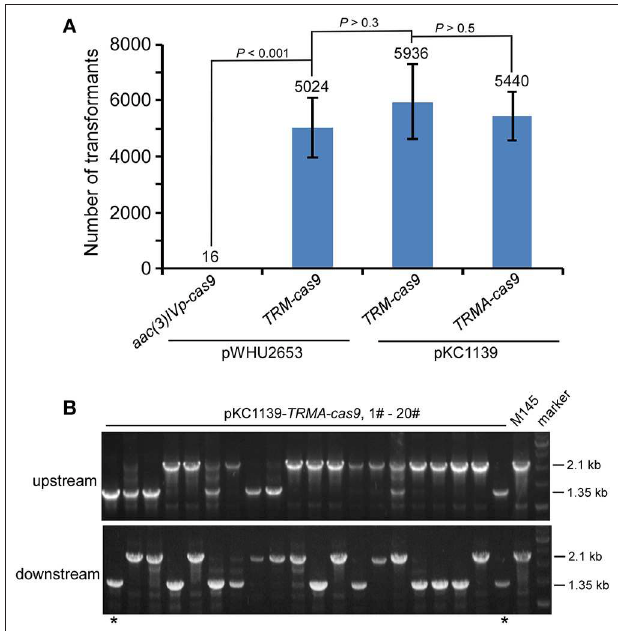
FIGURE 3 | actII-ORF4 deletion in S. coelicolor with engineered Cas9 and atpD overexpression from the pSG5 ori plasmid under non-induction conditions. (A) Transformation efficiency for actII-ORF4 deletion in S. coelicolor with engineered controls of Cas9 activities as in Figure 2B , but based on the pSG5 ori plasmid. The estimated transformants were shown as mean ± SD (standard deviation) from three independent transformations, and the average transformant numbers were shown on the corresponding columns. Statistical significance ( P < 0.001) was determined by two-tailed unpaired Student’s test. (B) Diagnostic PCR for actII-ORF4 deletion based on the same strategy as Figure 2D , but with pSG5 ori on the pKC1139 plasmid. The successfully deleted strains were indicated with